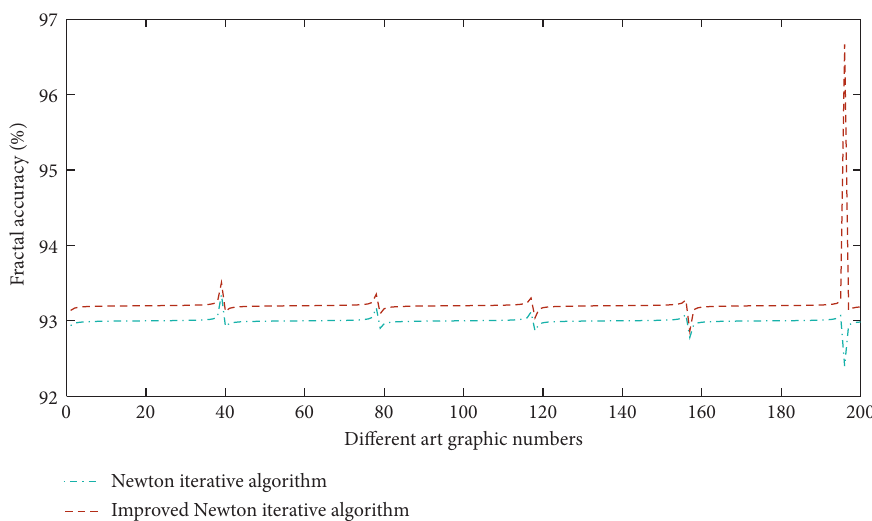
Figure 8: The fractal accuracy of artistic graphics of the Newton iterative algorithm before and after the